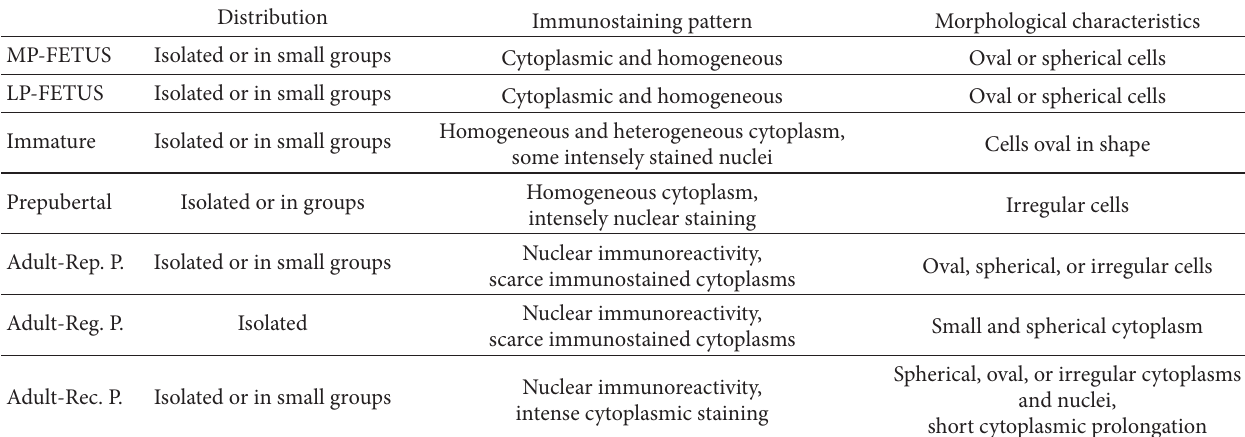
Table 1: AR expression in pituitary PD of male